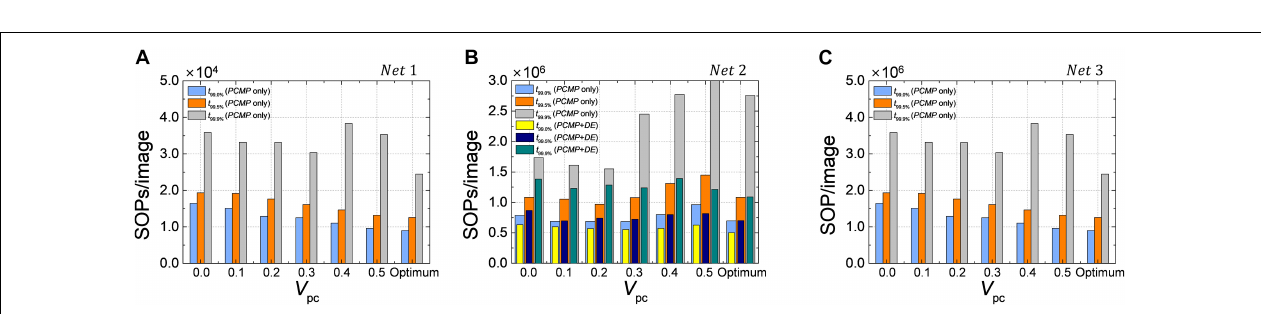
FIGURE 13 | The number of synaptic operations per image (SOPs/image) for (A) Net 1 , (B) Net 2 , and (C) Net 3 . SOPs/image is extracted based on t 99 . 0% , t 99 . 0% , and t 99 . 9% in the classification problems and on the reference MSE ( MSE @1-epoch without PCMP and DE ). The effect of the proposed methods for energy-efficient computing is remarkable.